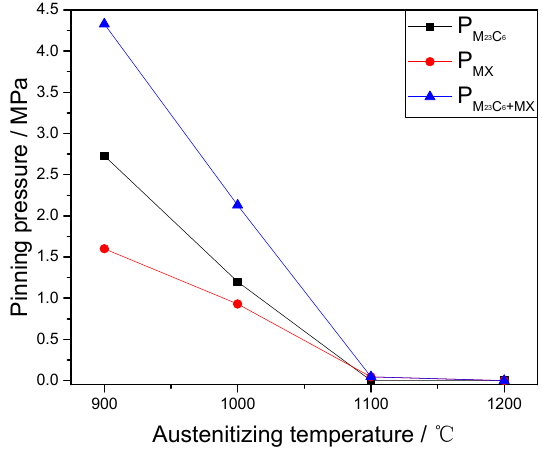
Figure 7. The pinning pressure at different austenitizing temperatures.